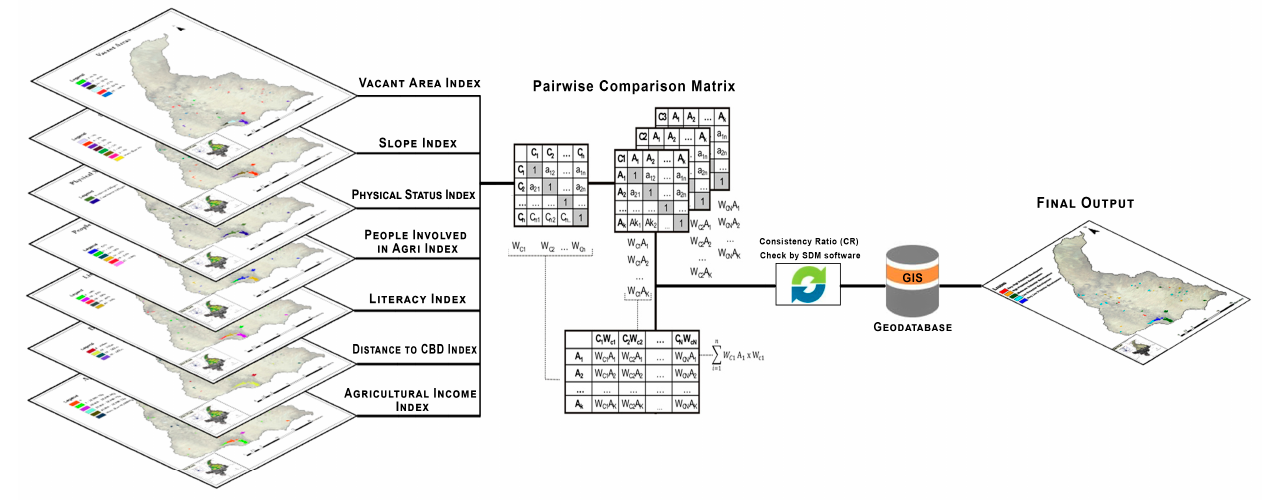
Figure 3. Research Methodology Diagram.